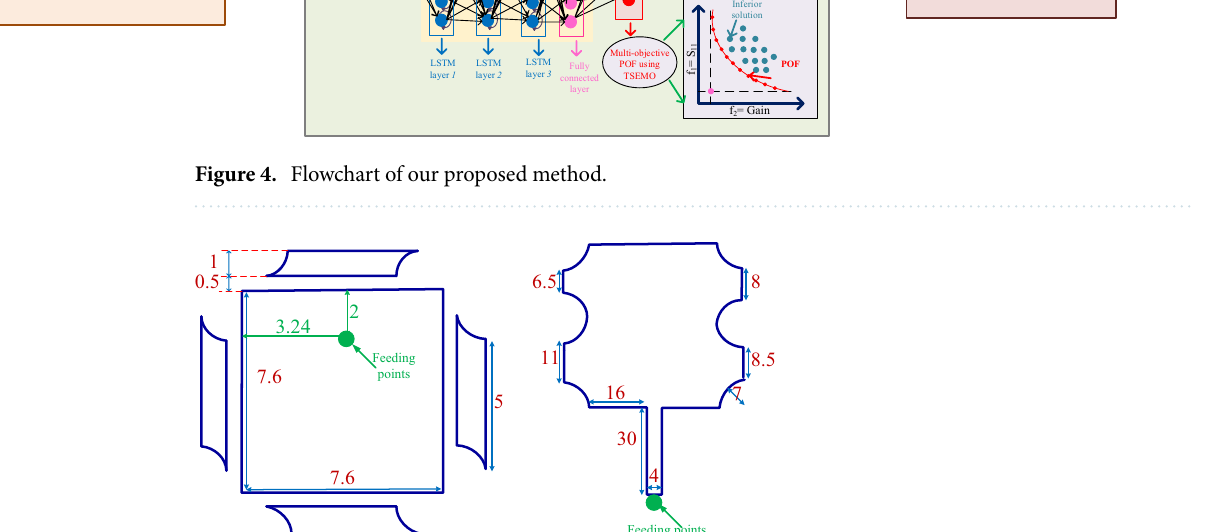
Figure 5. Initial configured antennas using the BUO method; antenna-1 (left) antenna-2 (right). Unit is